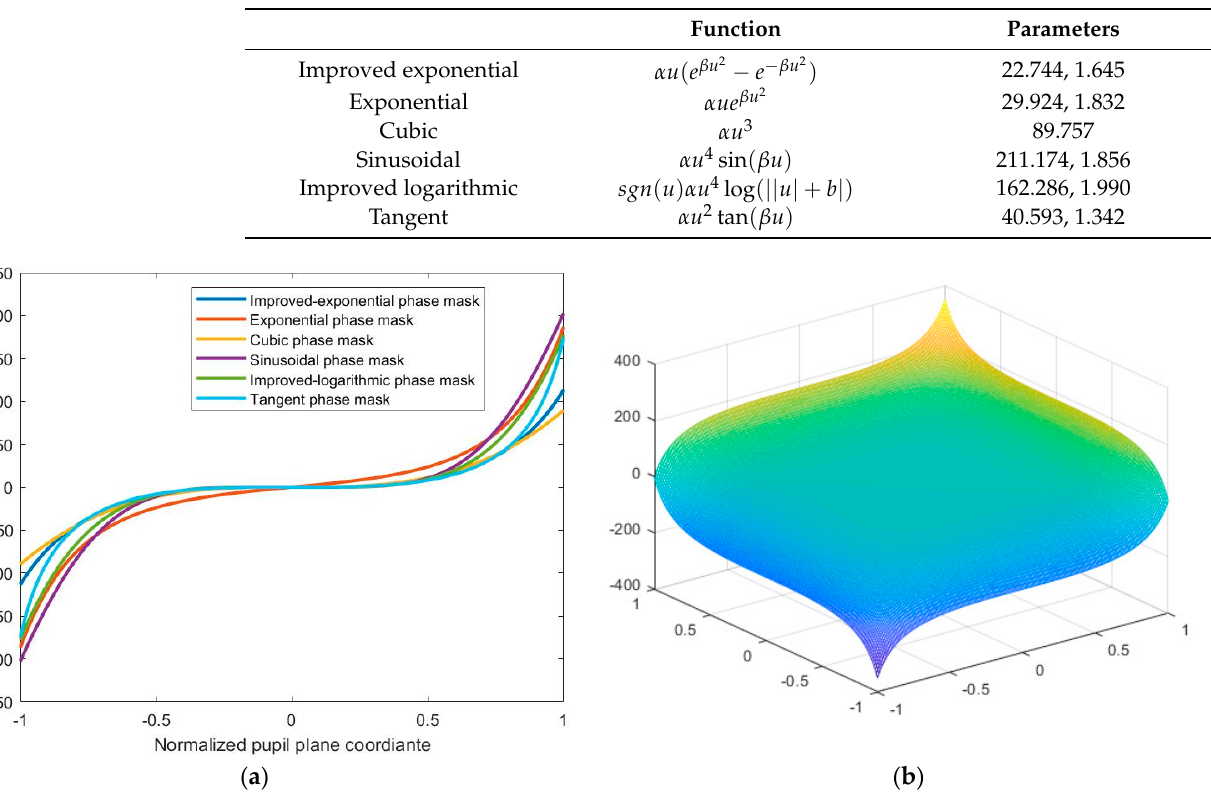
Figure 3. Phase profile ( a ) Phase profiles of improved exponential, exponential, cubic, sinusoidal, improved logarithmic, and tangent phase masks. ( b ) The two-dimensional phase profile of improved exponential phase mask.